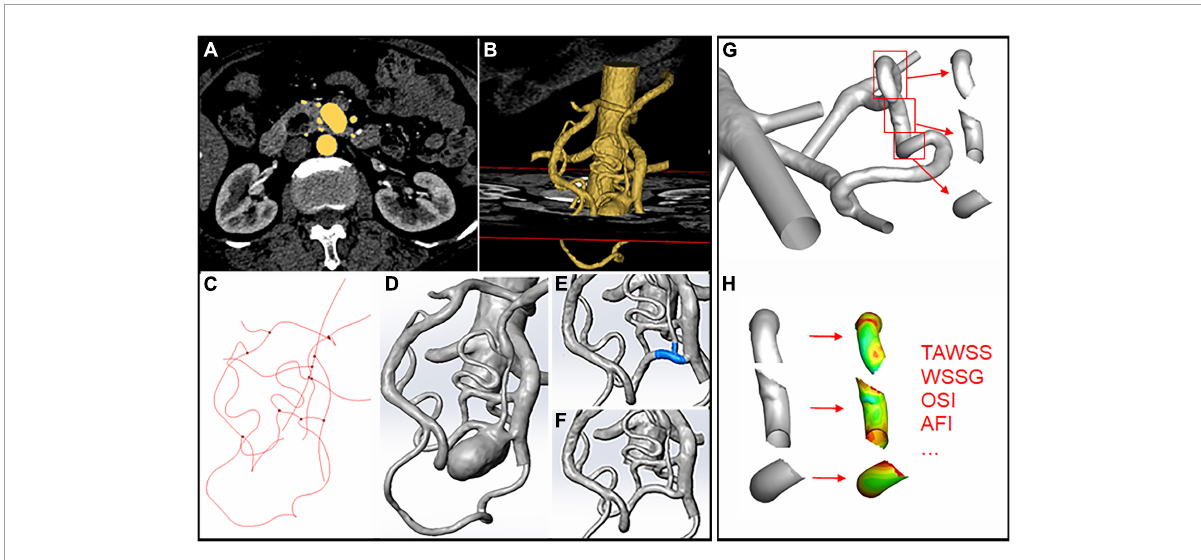
FIGURE1 Schematic illustration of aneurysm model construction and hemodynamics data extraction. (A,B) 3D segmentation of the artery models through CTA images. (C) Centerline calculation in Mimics. (D) Artery model loaded into Solidworks after smoothing. (E,F) Removal of the aneurysm through centerline interpolation and connection of the remaining branches. (G,H) Segmentation of the upstream, downstream, and aneurysm areas using the “blanking” function and hemodynamic parameters.